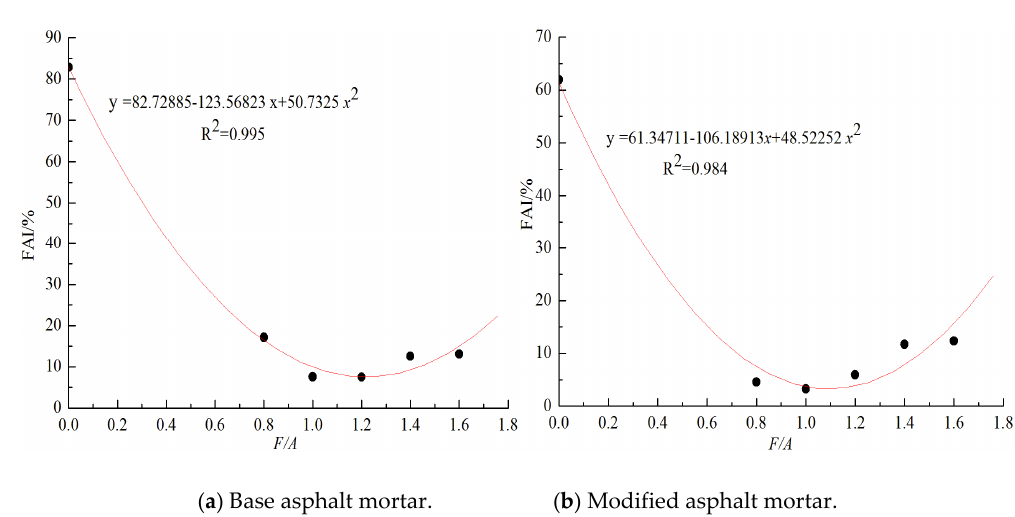
Figure 11. Fatigue factor ( G *sin δ ) on asphalt mortar.